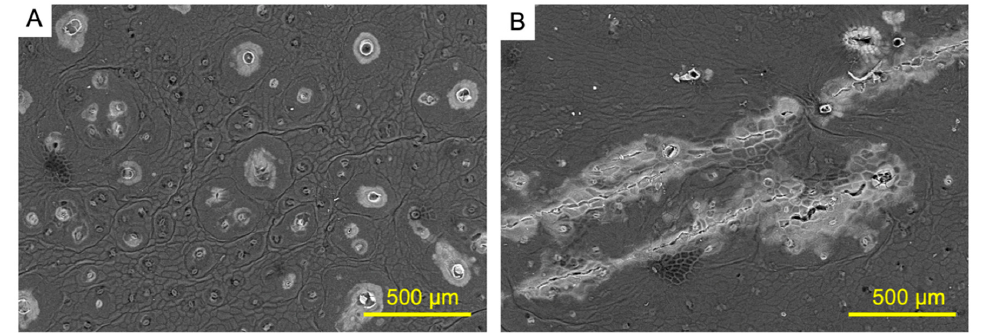
Figure 6. Scanning electron microscope images from normal oriental melon fruit suture surface ( A ) and brown surface of fruit suture ( B ).